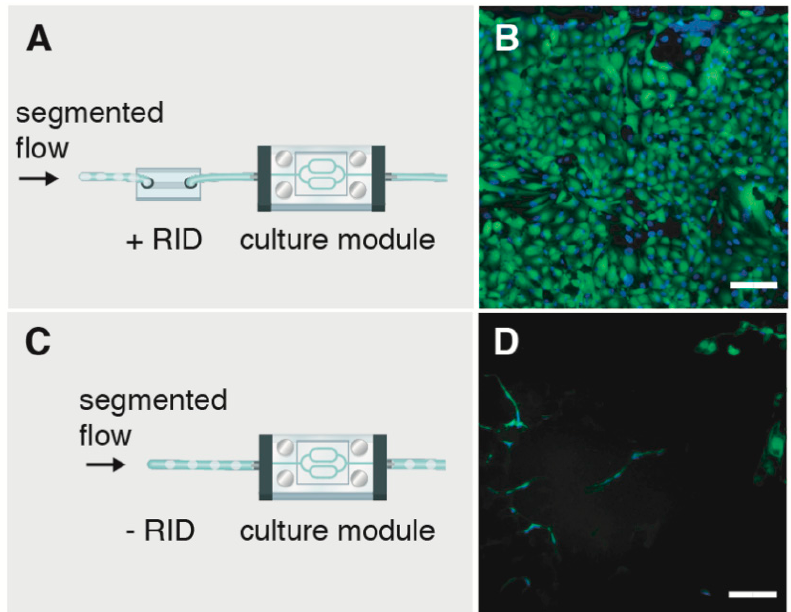
Figure 5. Representative images showing the importance of the RID module to protect against bubble-induced damage. Segmented flows were introduced upstream of the cultured cells ( A ) with a RID module and ( C ) without the RID module in place. ( B ) With the RID in place the cell population remained viable, while without the module ( D ) bubbles entering the channel caused damage to cell membranes. Scale bar = 100 μ m.